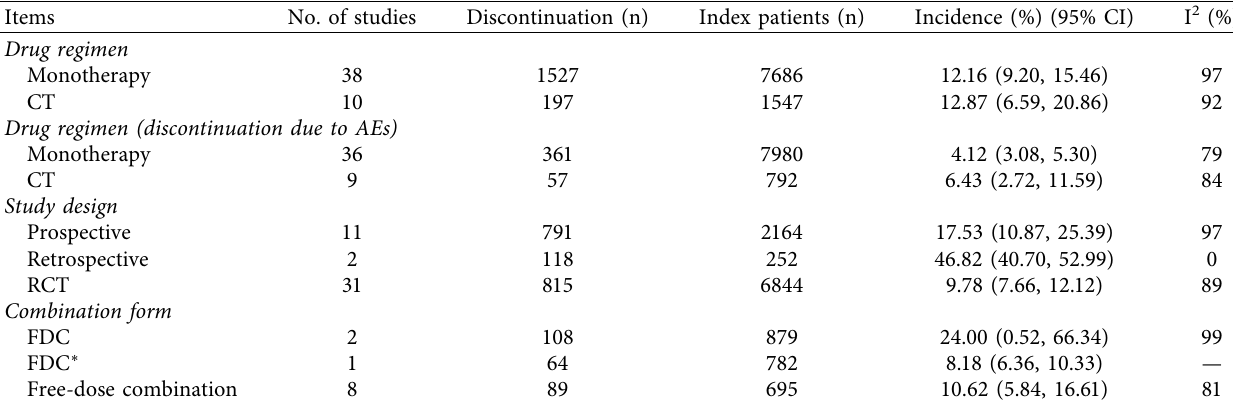
Figure 3: Forest plot illustrating the discontinuation rate due to AEs and no efcacy. (a) AEs, (b) No efcacy. AEs: adverse events; CI: confdence Table 2: Results of subgroup analysis of the incidence of discontinuation with tadalafl alone or in combination with ABs for LUTS patients with or without ED.